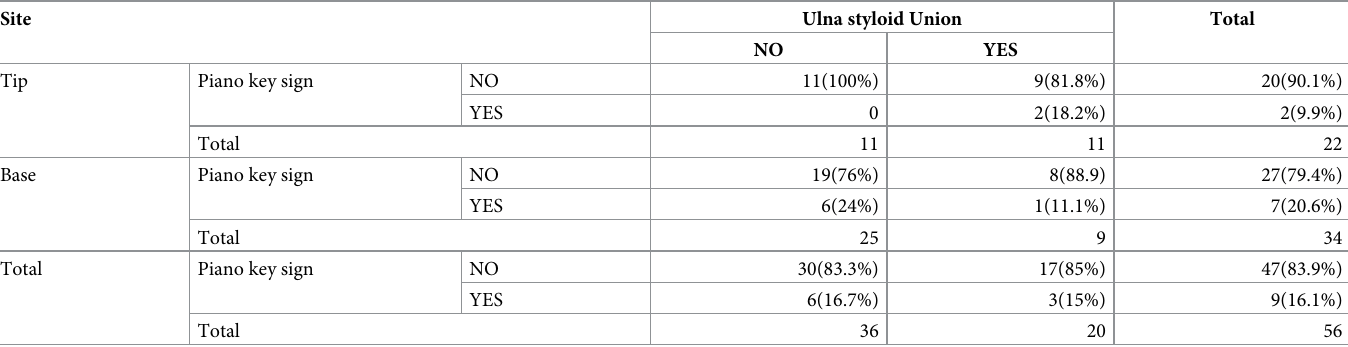
Table 3. Shows the relationship of the piano key sign to the site of fracture and union.